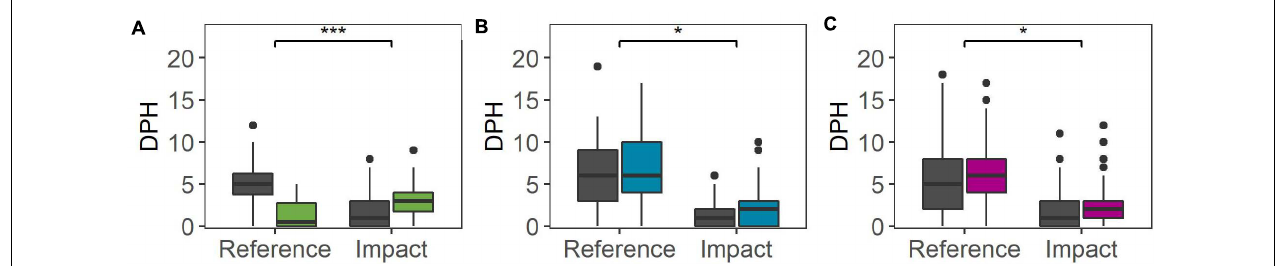
FIGURE 5 | Dolphin Detection Positive Hours (DPH) in the inner Moray Firth ( Reference Area ) and the southern Moray Firth ( Impact Area ) during the Baseline period (dark gray) and the Activity period (colored) on the small temporal scale: (A) 2D seismic survey, (B) Beatrice wind farm construction and (C) Moray East wind farm construction. Significance of the interaction between period and area is indicated above the bar at the top: *** P < 0.001; * P < 0.05.